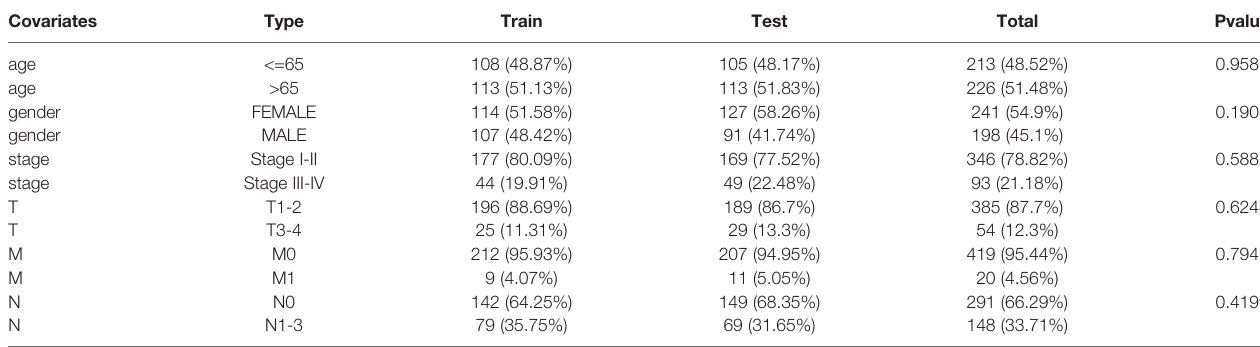
TABLE 1 | Clinical information for three LUAD patients sets in this study.